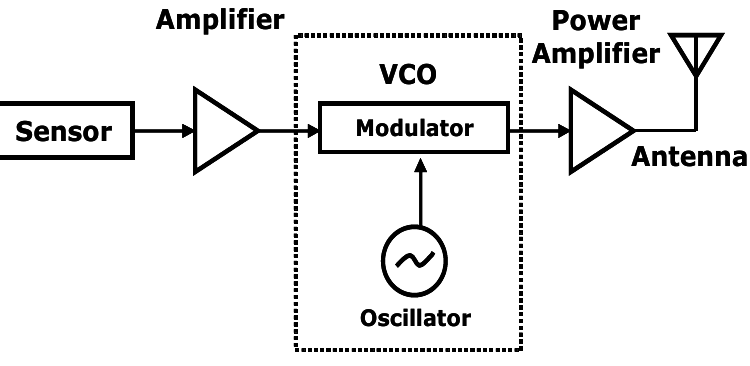
Oscillator Oscillator